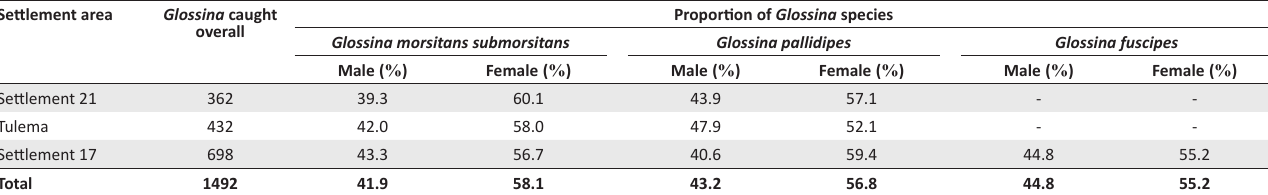
TABLE 2: Proportion of male and female Glossina species. Settlement area